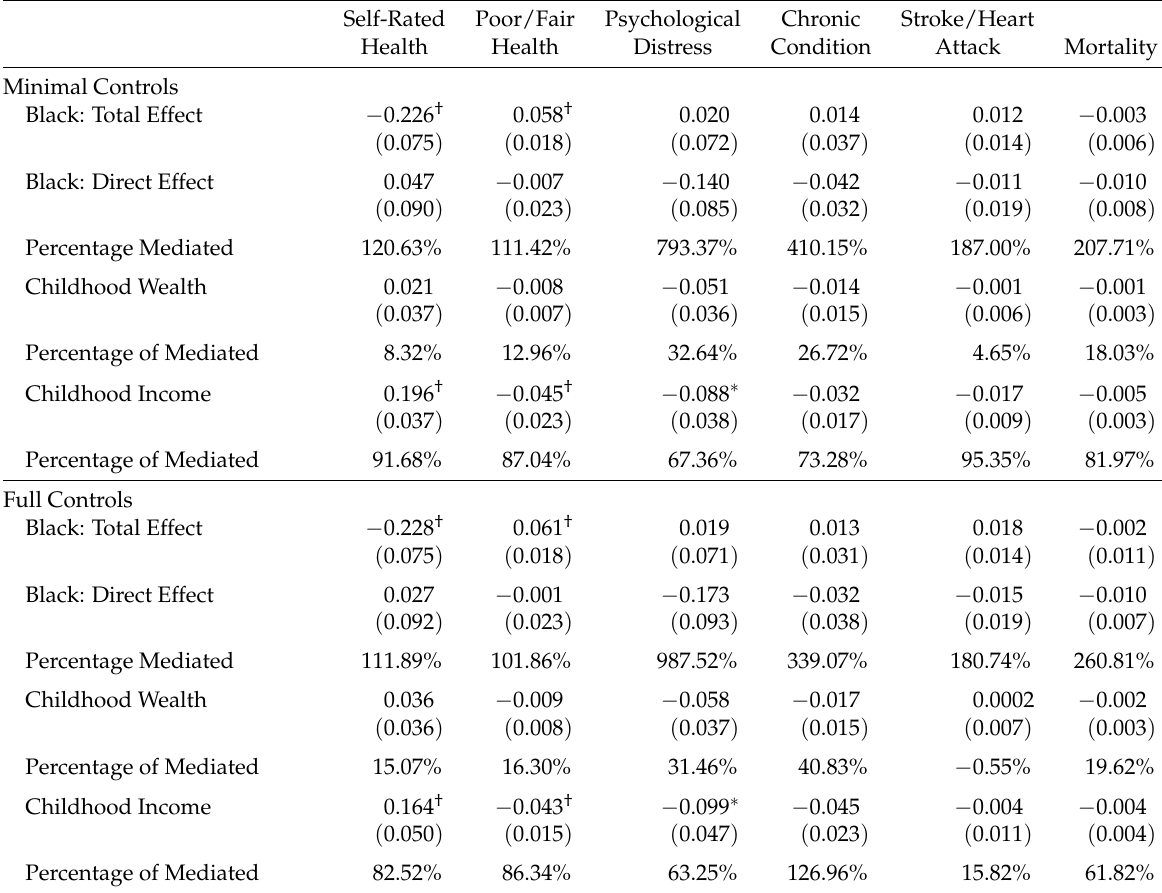
Table 3: Health outcomes: y -standardized coefficients or AMEs for being black and standardized coefficients or x -standardized AMEs for childhood wealth and